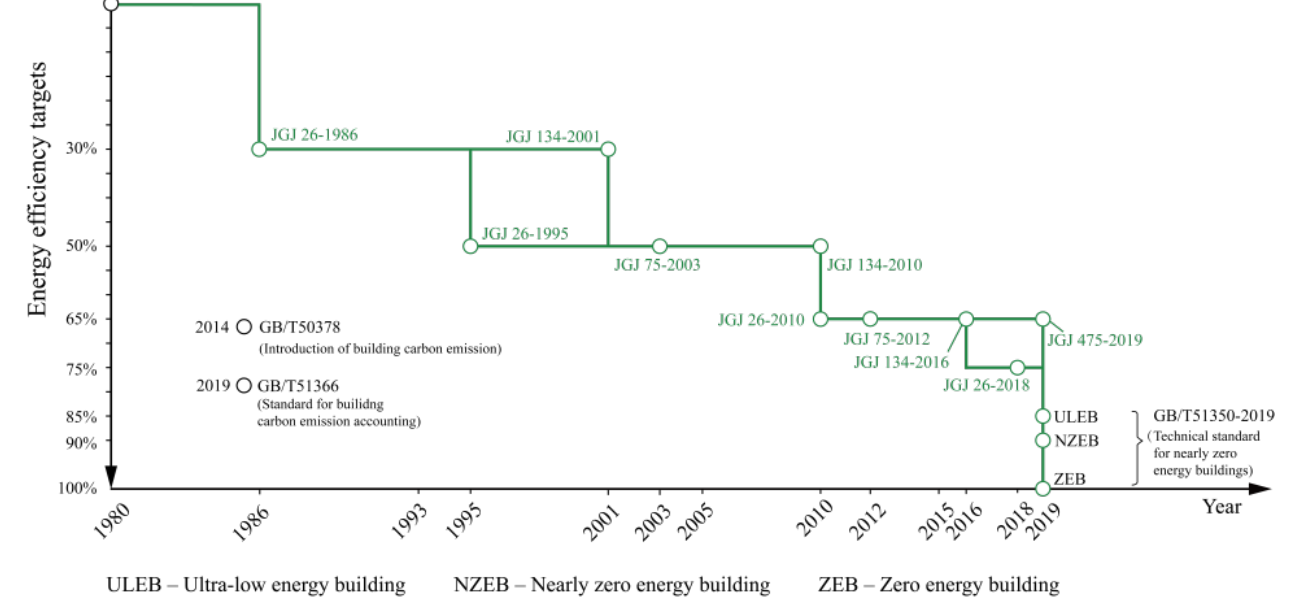
Figure 7. Carbon mitigation strategies of China’s residential building operations.